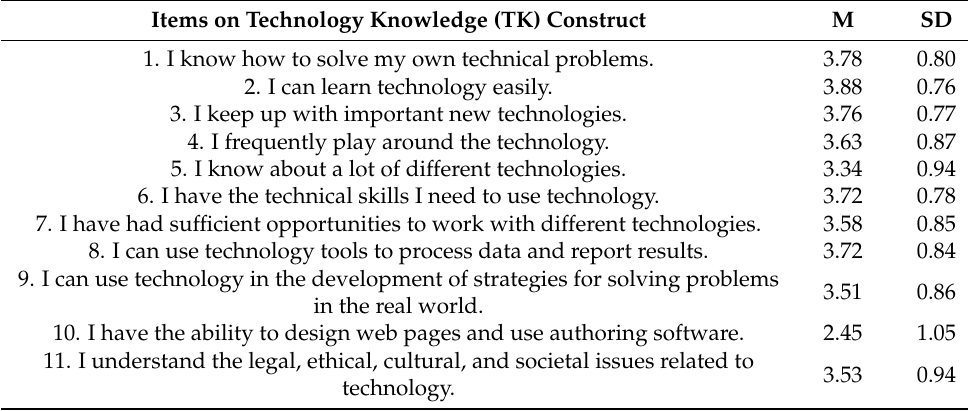
Table 4. Statistics on Technology Knowledge (TK) construct for all